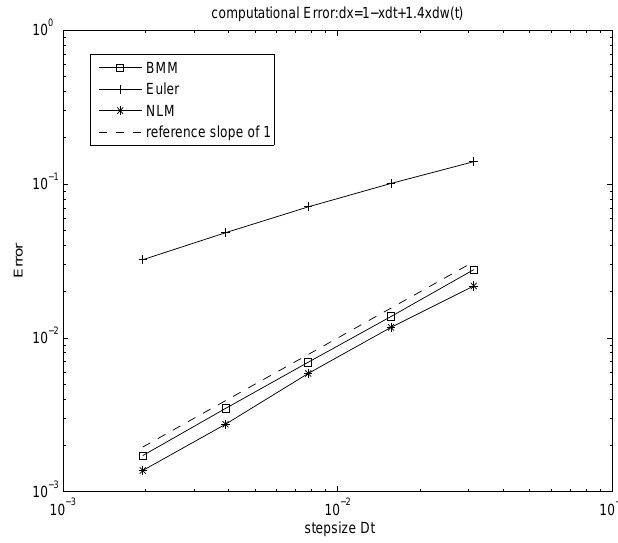
Figure 5. L 2 -error for the equation: dx = ( 1 − x ) dt + 1.4 xdW . The time interval: [ 0,1 ] , the number of simulated paths: